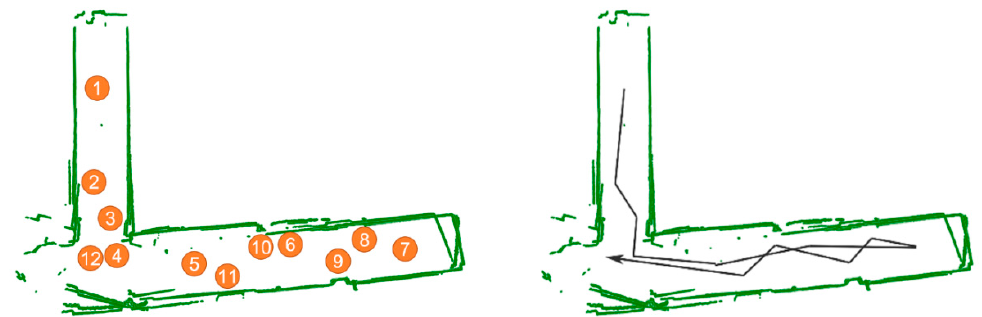
Figure 23. Integrated image of scanned result in second autonomous scanning experiment. The numbers indicate the positions after movement form the starting position of the autonomous scanner ( left ); also, the trajectory of the autonomous scanner is indicated ( right ).